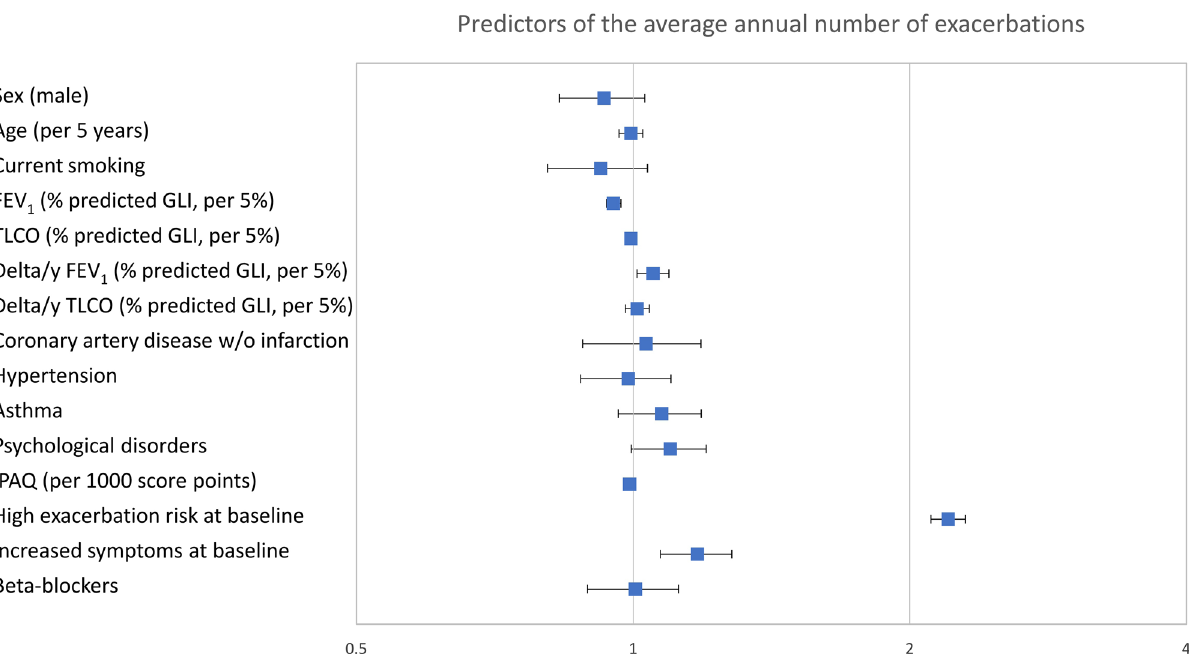
Figure 3. Predictors of the average annual number of exacerbations. Odds ratios and 95% confidence intervals for predictors of the mean annual number of exacerbations according to Poisson regression analysis. The numerical values correspond to those of Supplementary Table 4. The predictors shown are those which were statistically significant ( p < 0.05) in multivariable analyses of either increased mortality or rate of exacerbations to ensure comparability with Fig. 2, additionally asthma as important respiratory comorbidity. All predictors except for the decline in lung function (delta/y) refer to baseline values at the initial visit. Increased COPD symptoms correspond to GOLD groups B or D and high exacerbation risk to GOLD groups C or D at baseline.